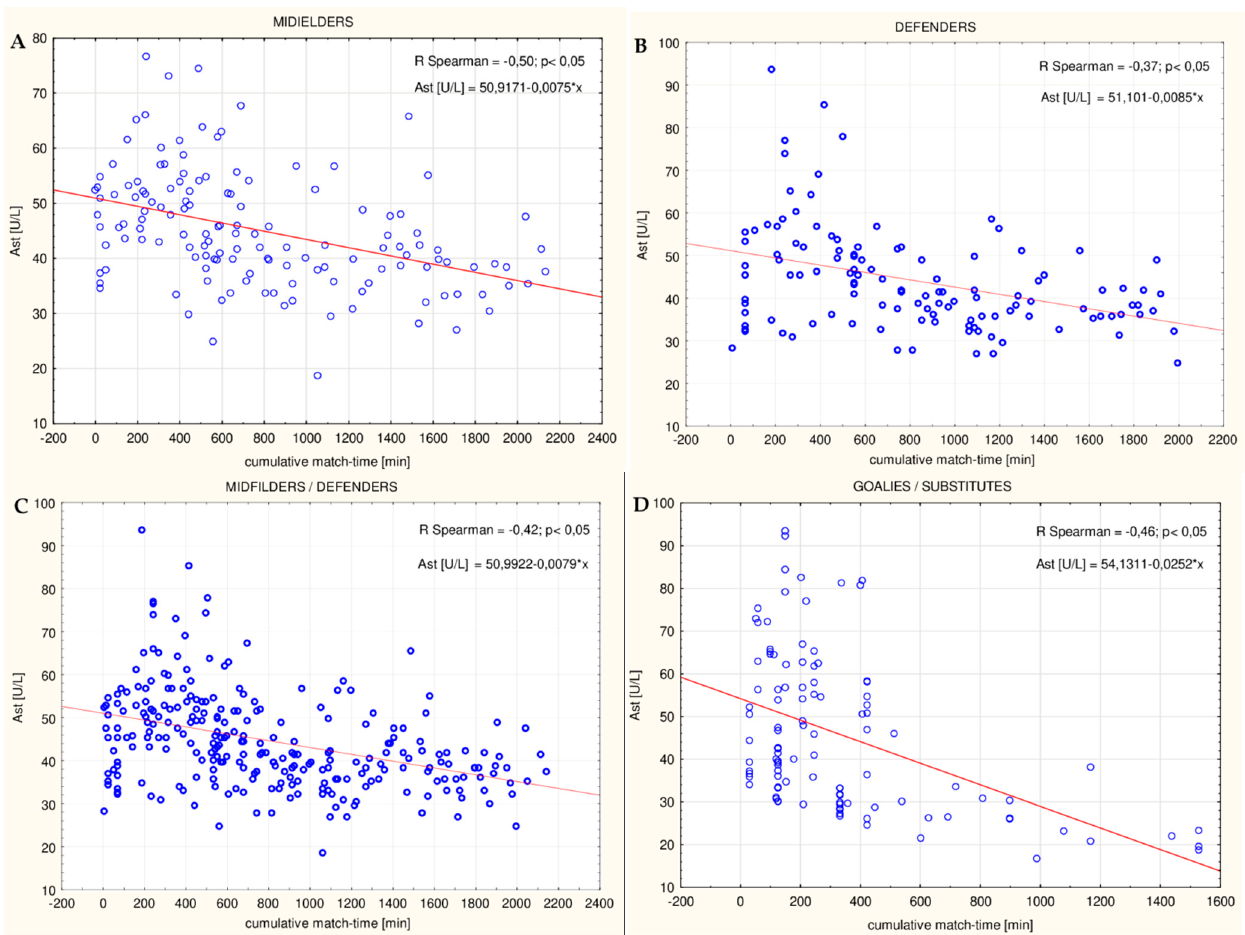
Figure 10. Correlation between cumulative match-time and aspartate aminotransferase activity (AST) in: ( A ) The midfielder, ( B ) defender, ( C ) midfielder and defender, and ( D ) goalie and substitute subgroups over the course of the autumn round of the soccer match season (the Spearman R correlation coefficient was determined).